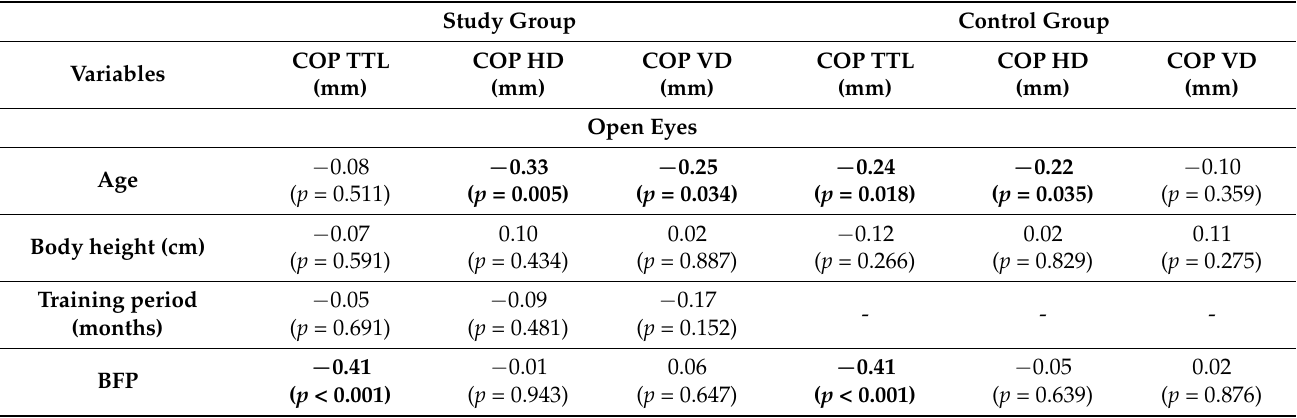
Table 6. Relationship between the values of the center-of-pressure and selected factors in the study and control